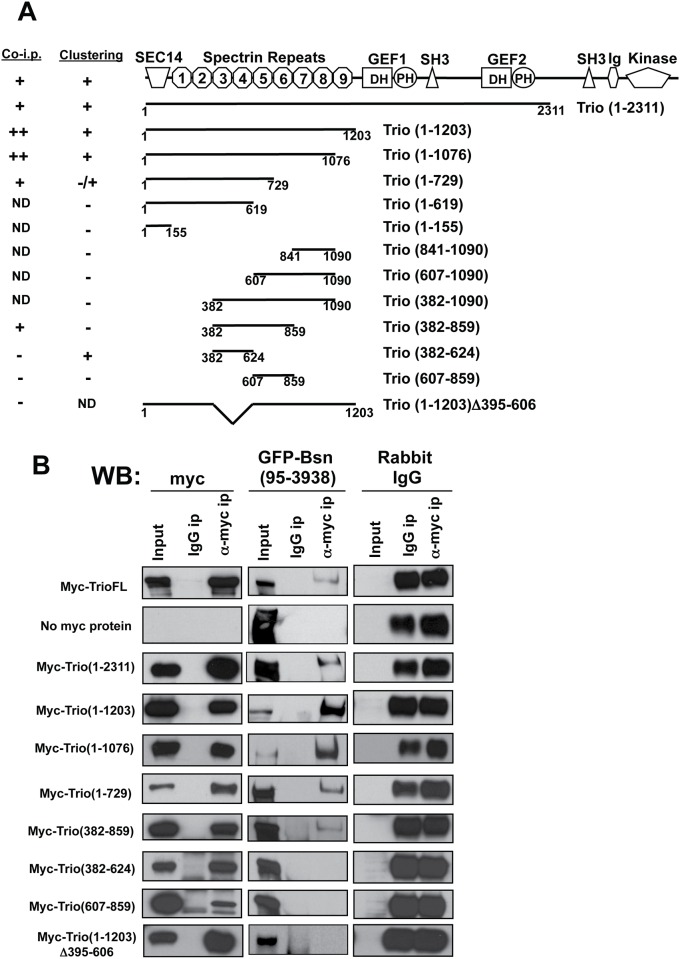
Spectrin repeats 3 and 4 of Trio are required for co-immunoprecipitation (co-IP) with Bassoon (Bsn).(A) Schematic diagram depicting FL-Trio and the polypeptides used in the clustering and co-IP assays. Column labeled “Clustering” summarizes the ability of different Trio mutants to bind GFP-Bsn (95–3938). Column labeled “Co-IP” contains a similar analysis for Trio constructs co-immunoprecipitated with GFP-Bsn (95–3938)(as shown in panel B). ND = not determined. (B) Western blot showing co-IP of GFP-Bsn95-3938 with Myc-Trio polypeptides (using Myc antibody) from COS7 cell lysates. Blots in left column (Myc) show levels of Myc-Trio constructs in total lysates (input), after control IP with rabbit IgG (IgG IP), and after IP with Myc antibody (α-Myc ip). Middle column (GFP-Bsn) shows GFP-Bsn 95–3938 levels for the same conditions, as detected with anti-GFP antibody. Right column shows Rabbit IgG, demonstrating that similar levels of antibody were used in the α-Myc and control conditions.